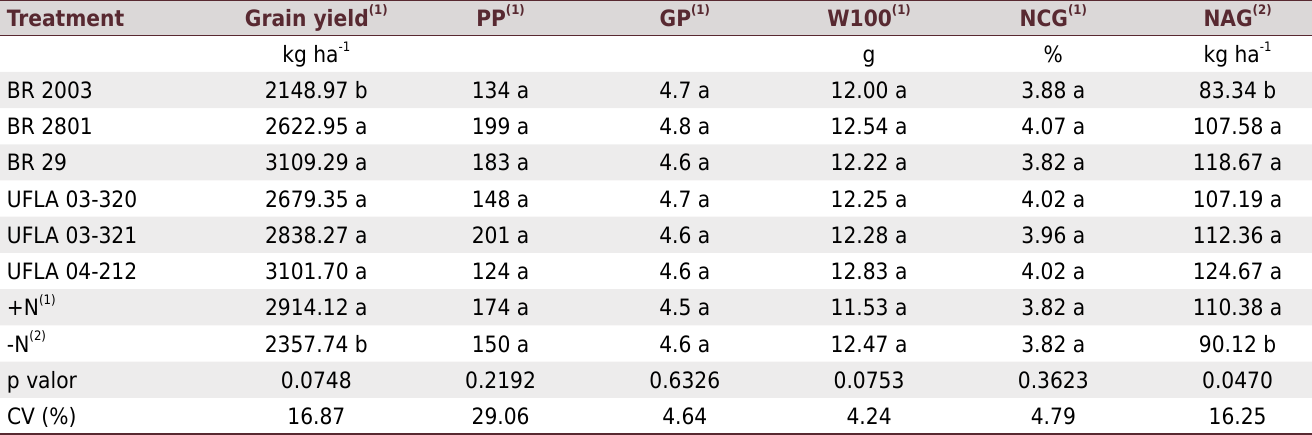
Table 7. Mean values of grain yield and its main components [pods per plant (PP), grains per pod (GP), 100-grain weight (W100)], nitrogen content in the grain (NCG), and nitrogen accumulation in the grain (NAG) of pigeon pea cv. IAC Fava-Larga cultivated in the field